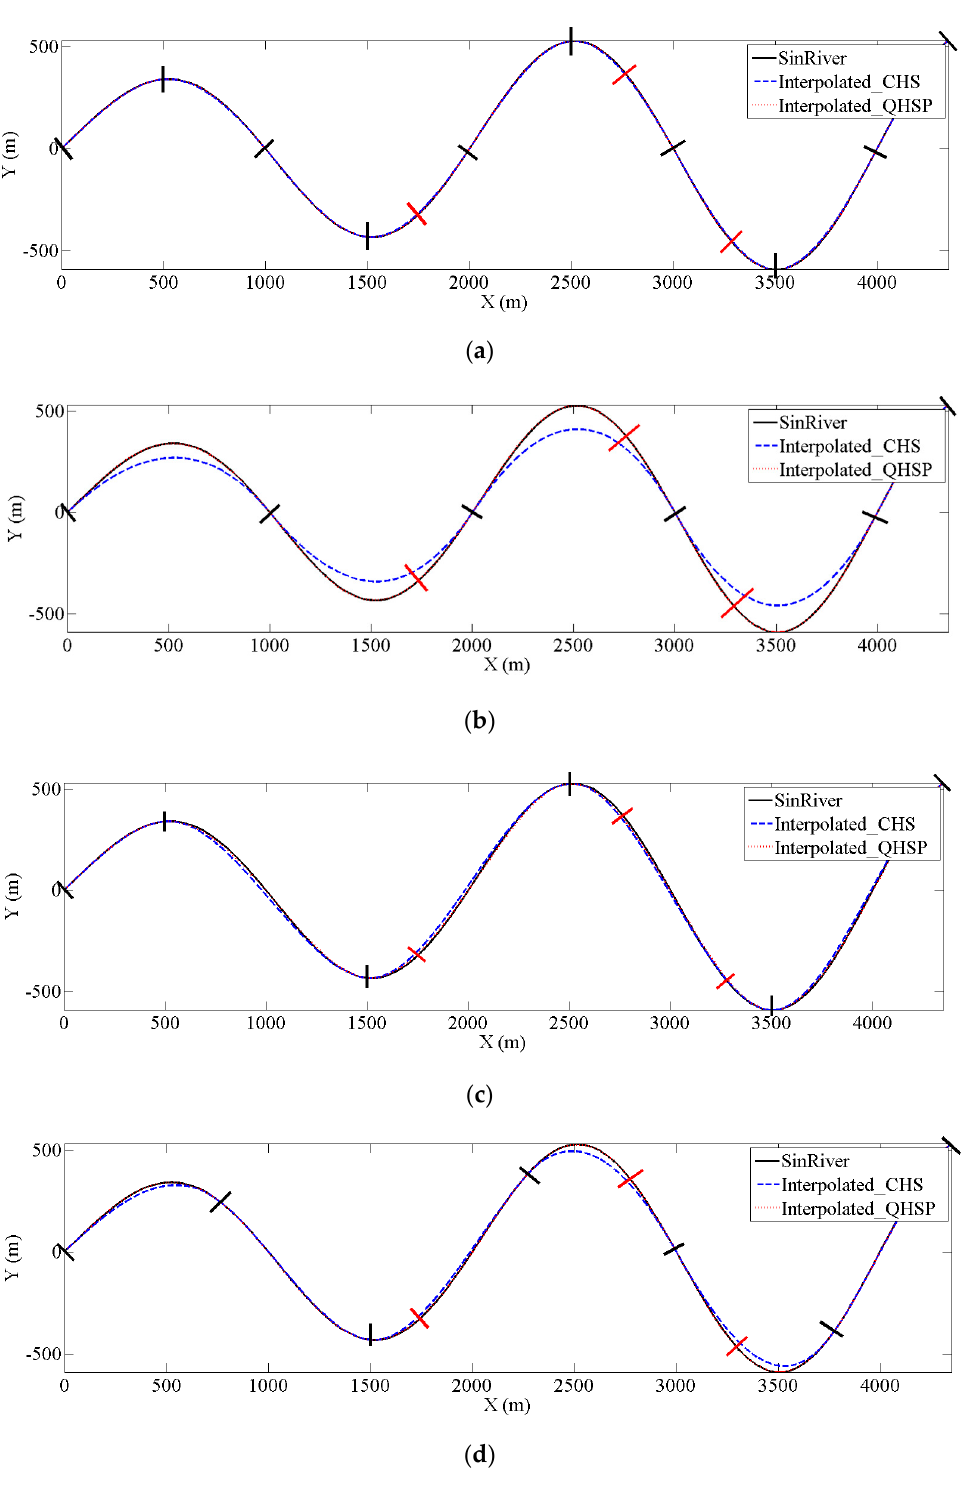
Figure 8. Constructed river thalweg in Case ( a ) A, ( b ) B, ( c ) C, and ( d ) D with the amplitude of 600